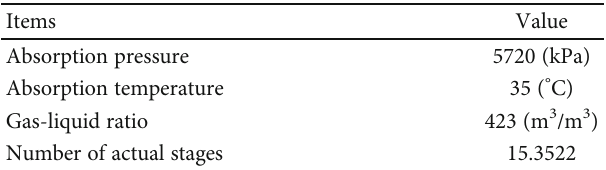
Table 3: Simple calculation results of the absorption tower. Items